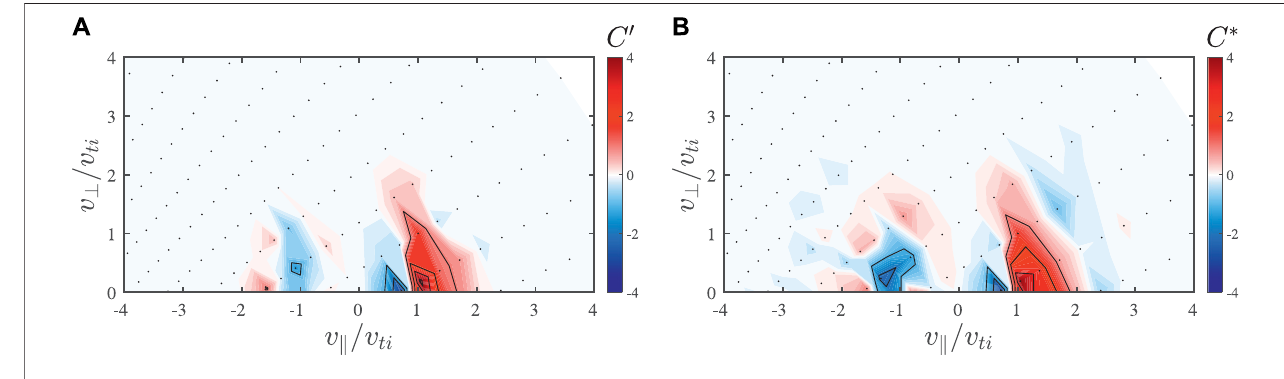
FIGURE 5 | (A) Example of the alternative parallel electric fi eld correlation C E (cid:3) ′ ( v (cid:3) , v ⊥ ) computed at a single spatial point in a gyrokinetic simulation of plasma turbulence and downsampled to the phase-space resolution of the SPAN-I instrument on Parker Solar Probe (Verniero et al., 2021a), compared to (B) the signature determined from applying the PATCH algorithm C τ ′ ( v (cid:3) , v ⊥ ) , computed using N = 25 counts in the maximum density phase-space bin at the same phase-space resolution. From Verniero et al.